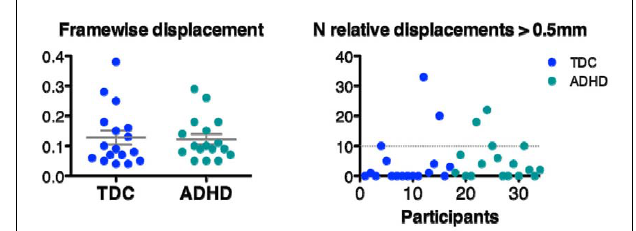
FIGUREA1 | Framewise displacement and N relative displacements calculated according to Power et al. (in